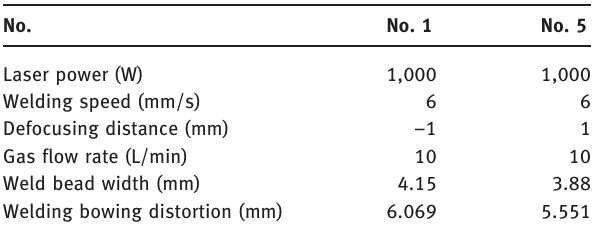
Table 11: Welding parameters and bead width corresponding to Figure